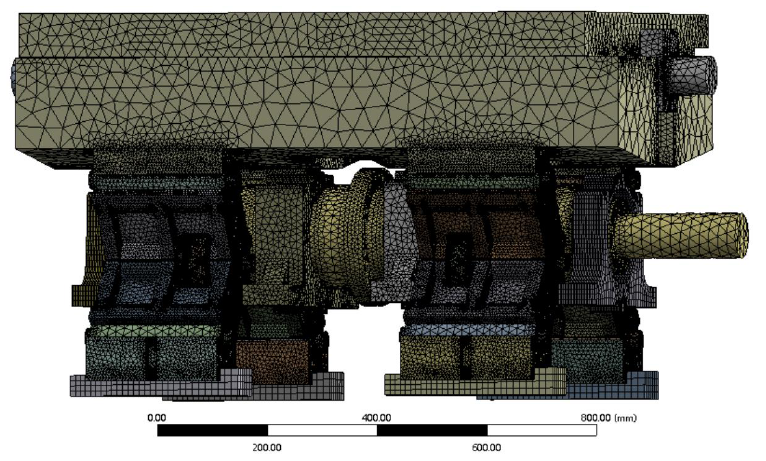
Figure 32. Meshing diagram of assembly.